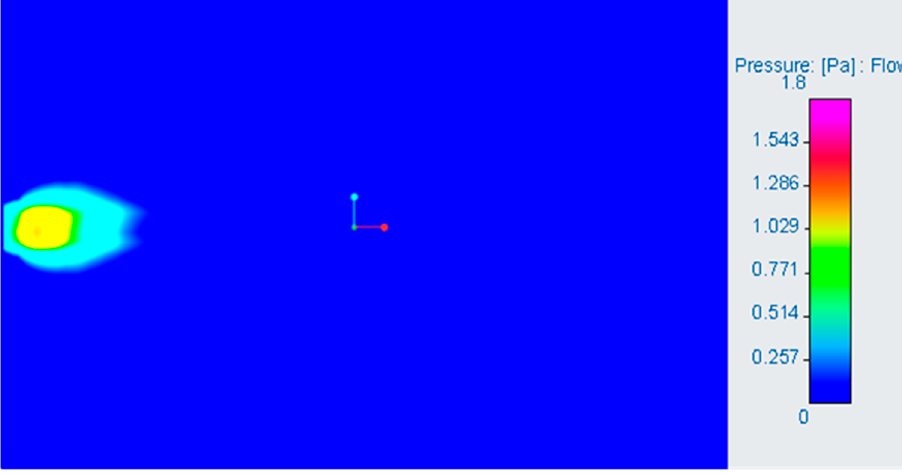
Figure 3. Surface pressure under conveying stream.